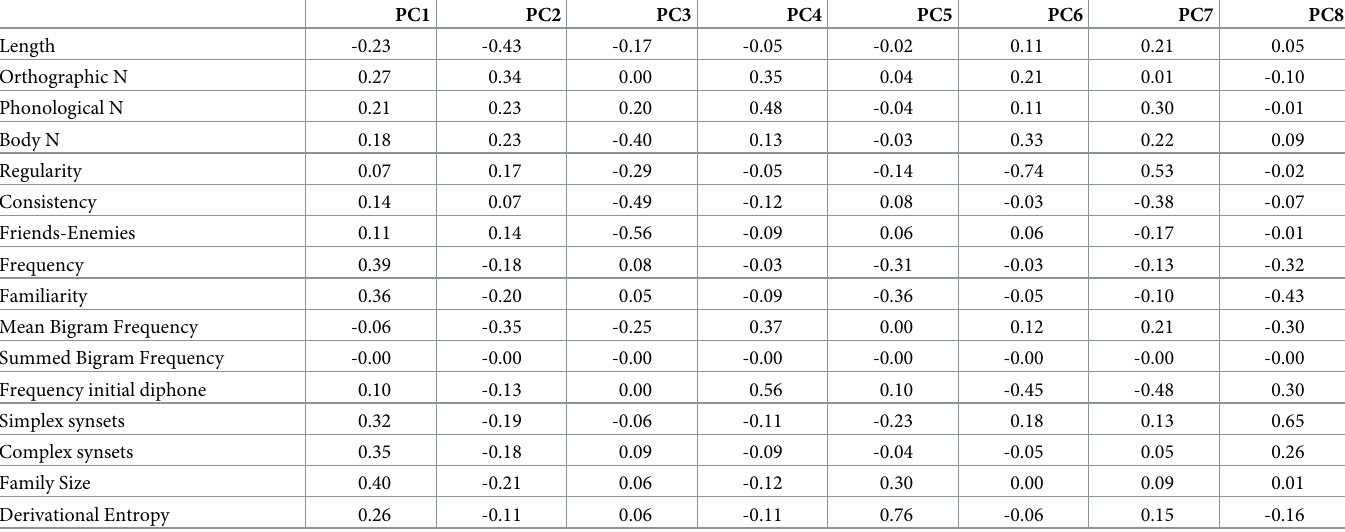
Table 4. Results of a principal components analysis on the 16 dimensional space described by the predictors. Listed are predictor loadings for the first 8 principal components.